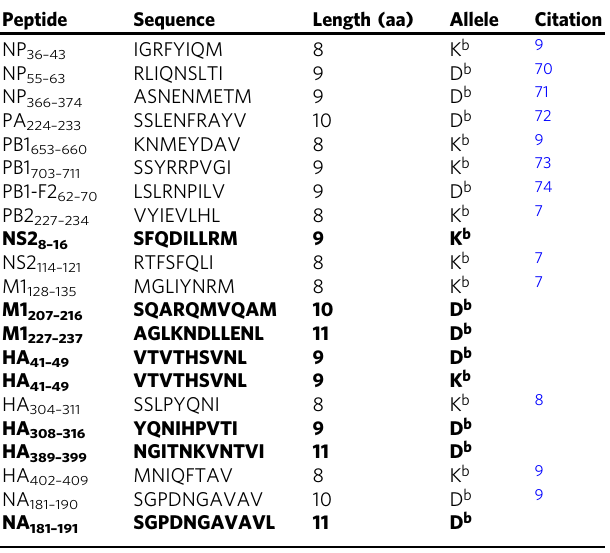
Table 1 Peptides identi fi ed from IAV-infected cells by LC- MS/MS